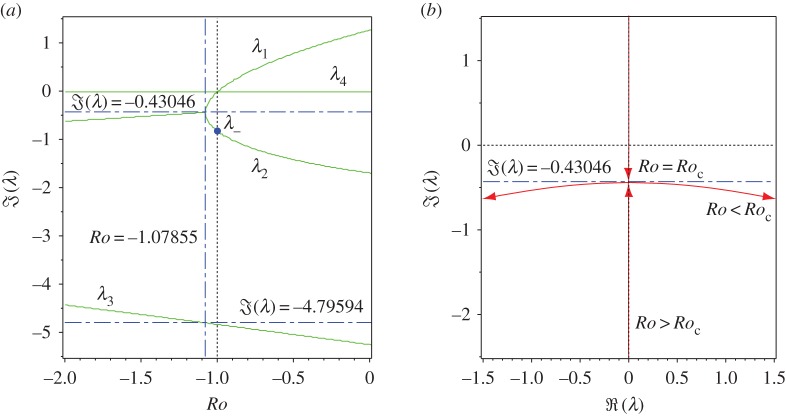
(a) Typical evolution of frequencies of the roots of the dispersion relation (3.12) as Ro is varied, shown for S=1, Rb=−1 and n=2 that correspond to crossing the neutral stability curve along the vertical dash-dot line in figure 1a. It demonstrates the Hamilton–Hopf bifurcation at Ro=Roc≈−1.07855 and the marginal stability of the Chandrasekhar energy equipartition solution at Ro= −1. (b) The same linear Hamilton–Hopf bifurcation shown in the complex plane: with the decrease in Ro, two simple imaginary eigenvalues collide into a double imaginary eigenvalue with the Jordan block (an exceptional point [8]) that subsequently splits into two complex eigenvalues (oscillatory instability). (Online version in colour.)